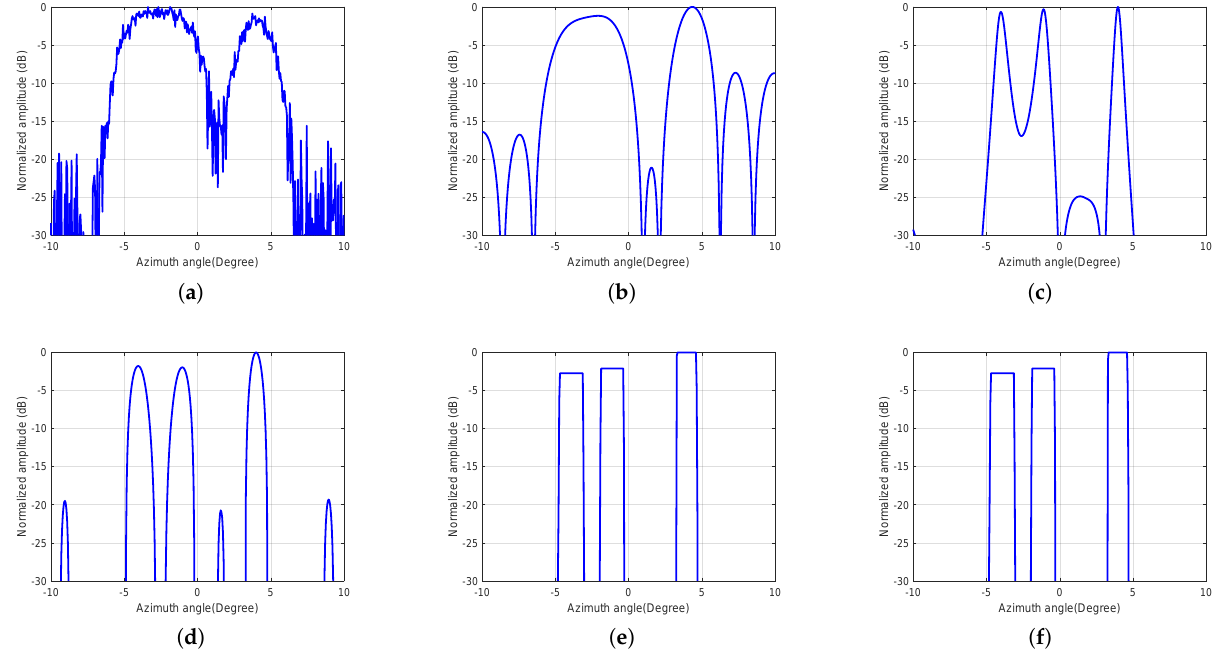
Figure 5. Processed results of the simulation. ( a ) Real beam echo, ( b ) truncated singular value decomposition (TSVD), ( c ) iterative adaptive approach (IAA), ( d ) Sparse, ( e ) total variation (TV), ( f ) Gohberg–Semencul (GS) representation based fast TV